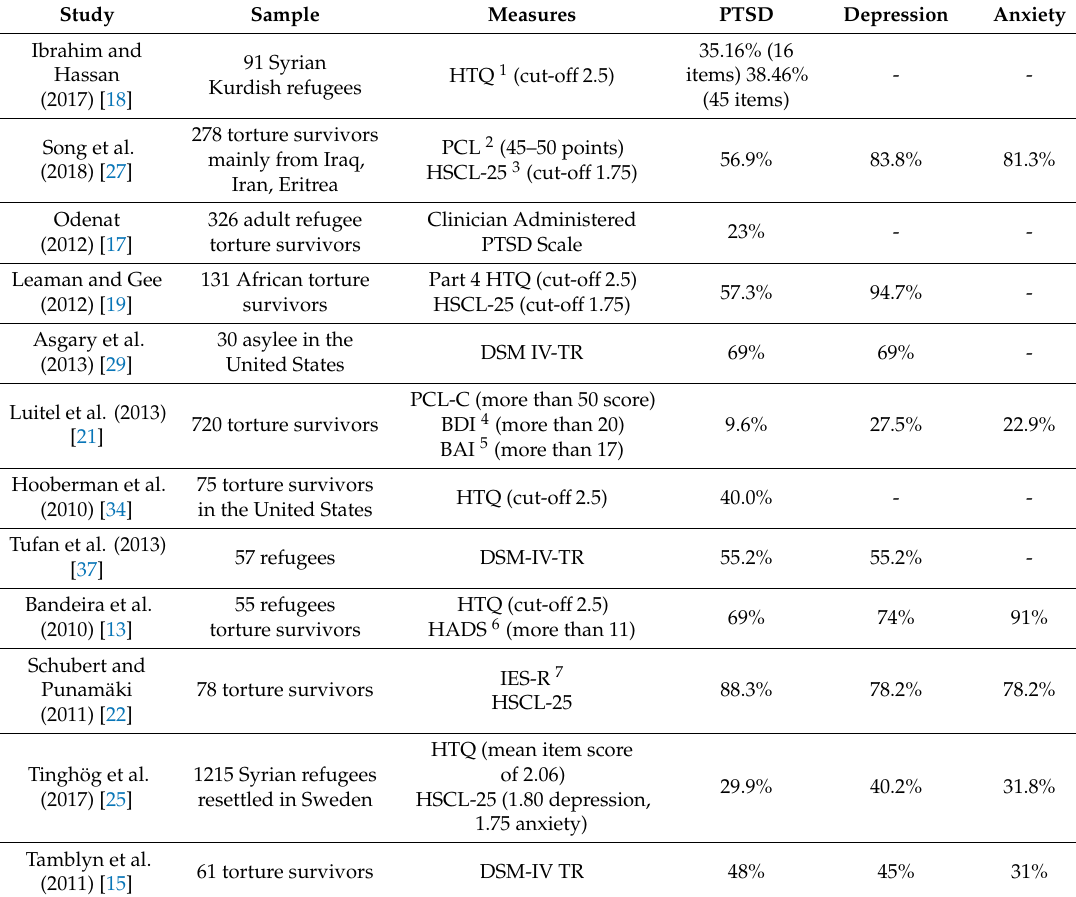
Table 3. Prevalence of mental health